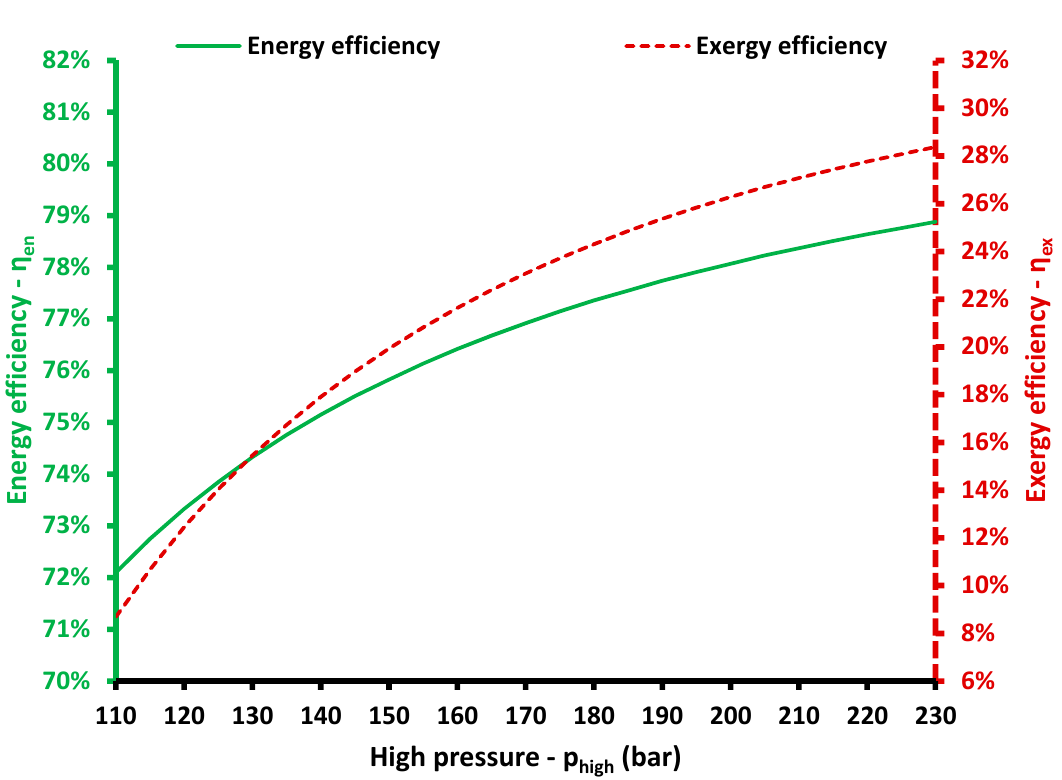
Figure 7. Energy and exergy efficiencies for different values of the high pressure.